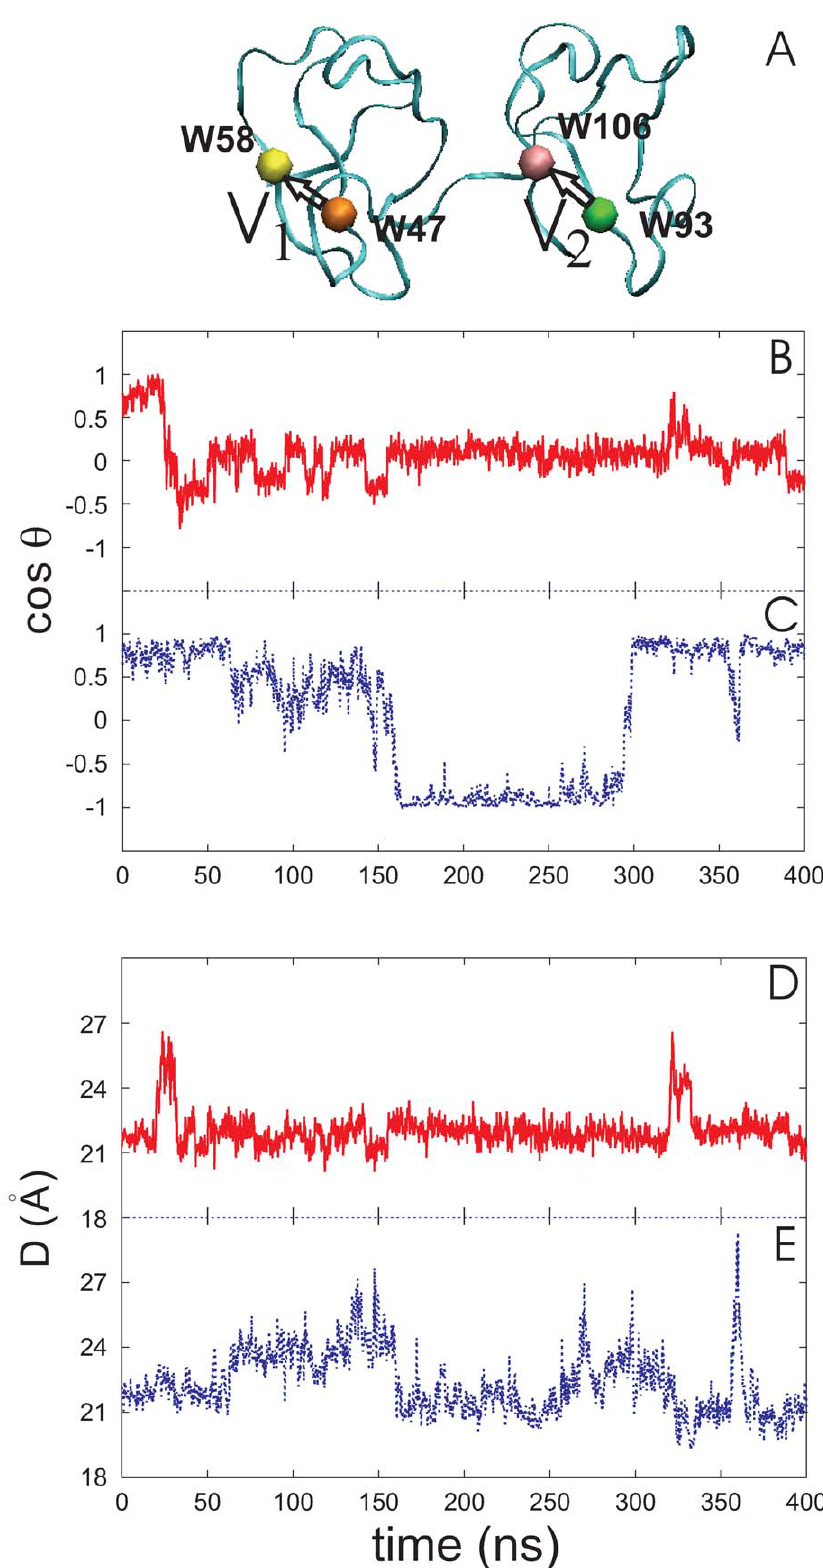
Figure 9. Relative orientation and distance of the two domains of PDC109. h is the angle between two vectors, V 1 and V 2 in (A) [74], defined as displacements of C a atom between W47 and W58 of PDC109/a and between W93 and W106 of PDC109/b, respectively. Fluctuations of cos h are shown for ligand-free PDC109 in red (B) and for PDC109 complexed with PhC in blue (C). Fluctuations of center-to-center distance D between two domains of PDC109 are in red (D) and of PhC-bound PDC109 are in blue (E).